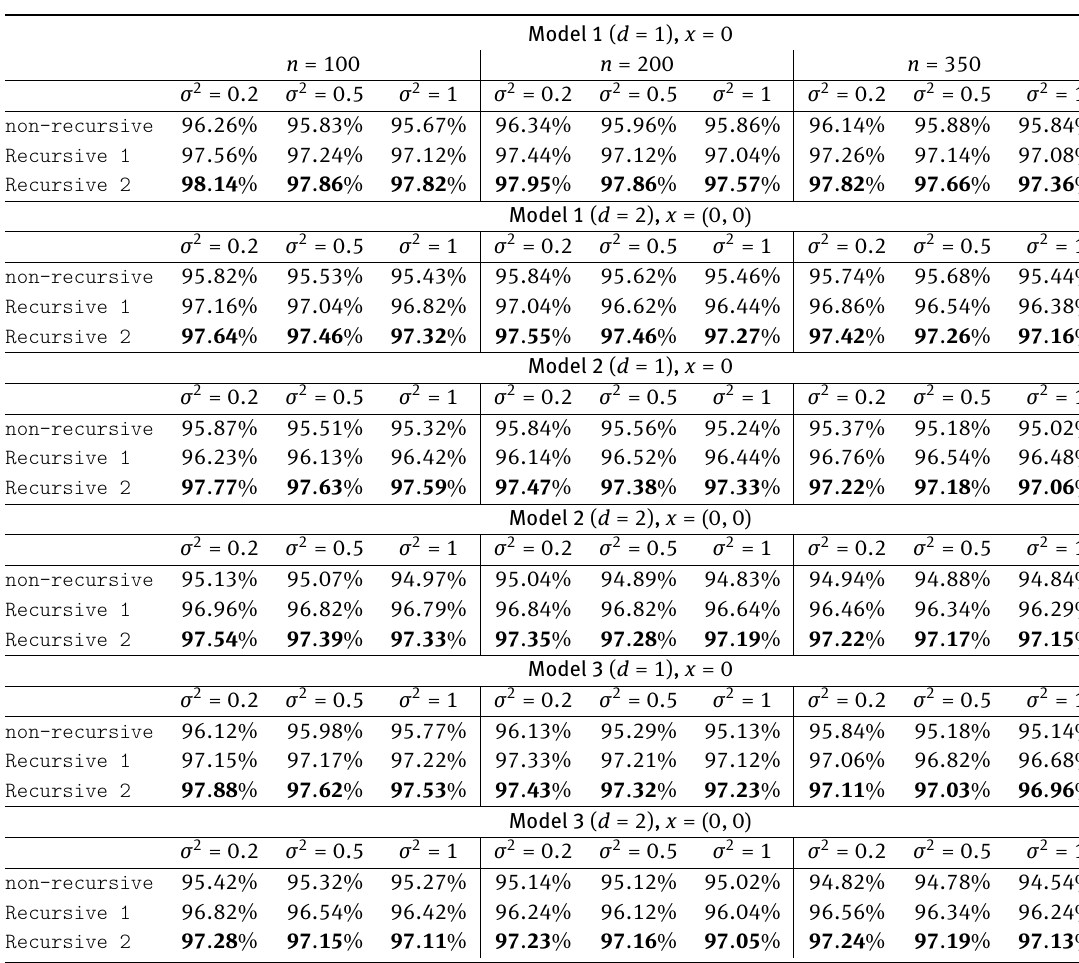
h k (cid:3)(cid:1) k =1